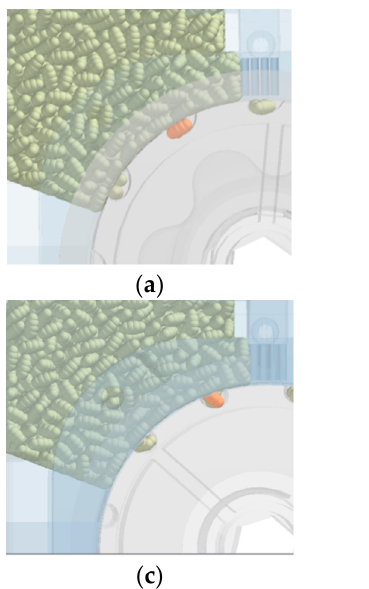
Figure 12. Seed filling posture. ( a ) Inverted-fin seed flat position; ( b ) Inverted-fin seed lateral position; ( c ) Bowl-shaped erect position; ( d ) Prism-shaped erect position.